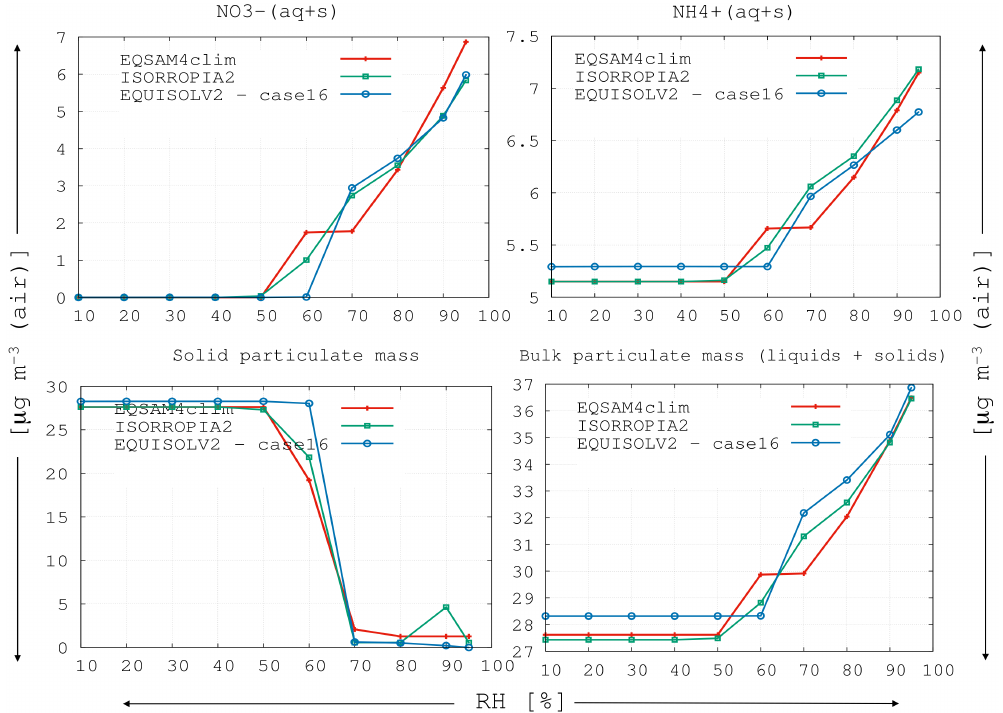
Figure 7. EQUISOLV II comparison – case 16. Bulk aerosol nitrate (ul), ammonium (ur), total solid PM (ll), liquid + solid PM (lr) as a function of RH for the sulfate molar ratios shown in Fig. 6. This figure is extended by Figs. S6 and